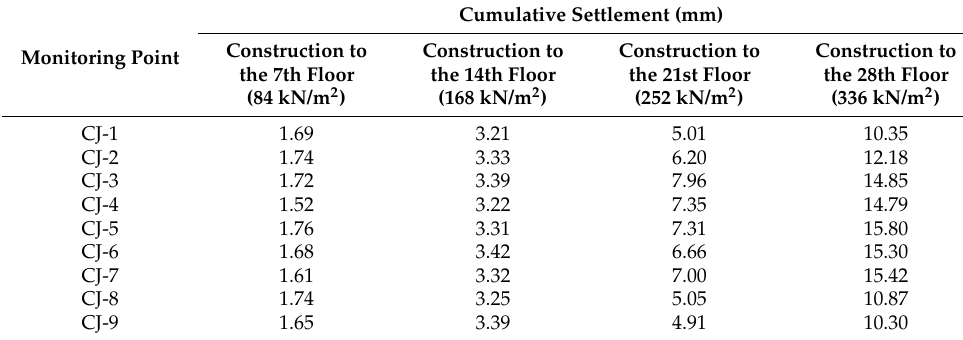
settlements at the right corner points CJ5 and CJ6 are 15.8 mm and 15.3 mm,